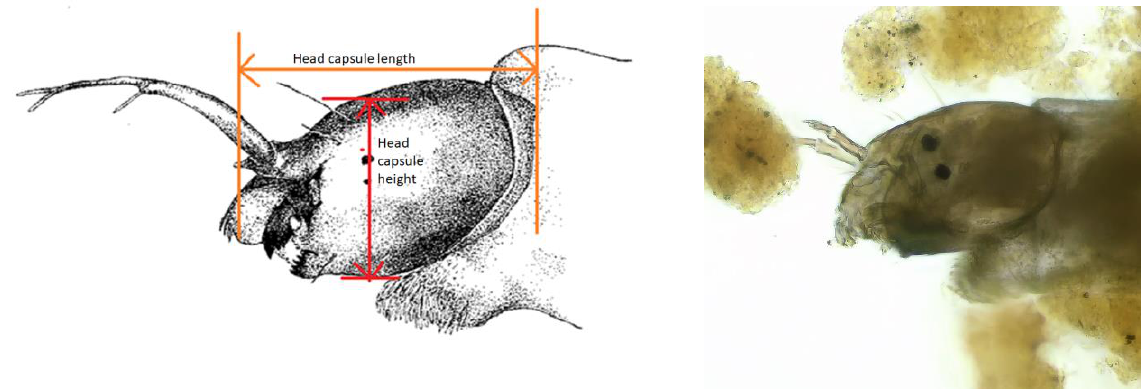
Figure 3. A lateral view of the head of a mosquito larvae ( Tanytarsus sp.). Drawing modified from Carew [18], right figure microscopic view, Michels © .